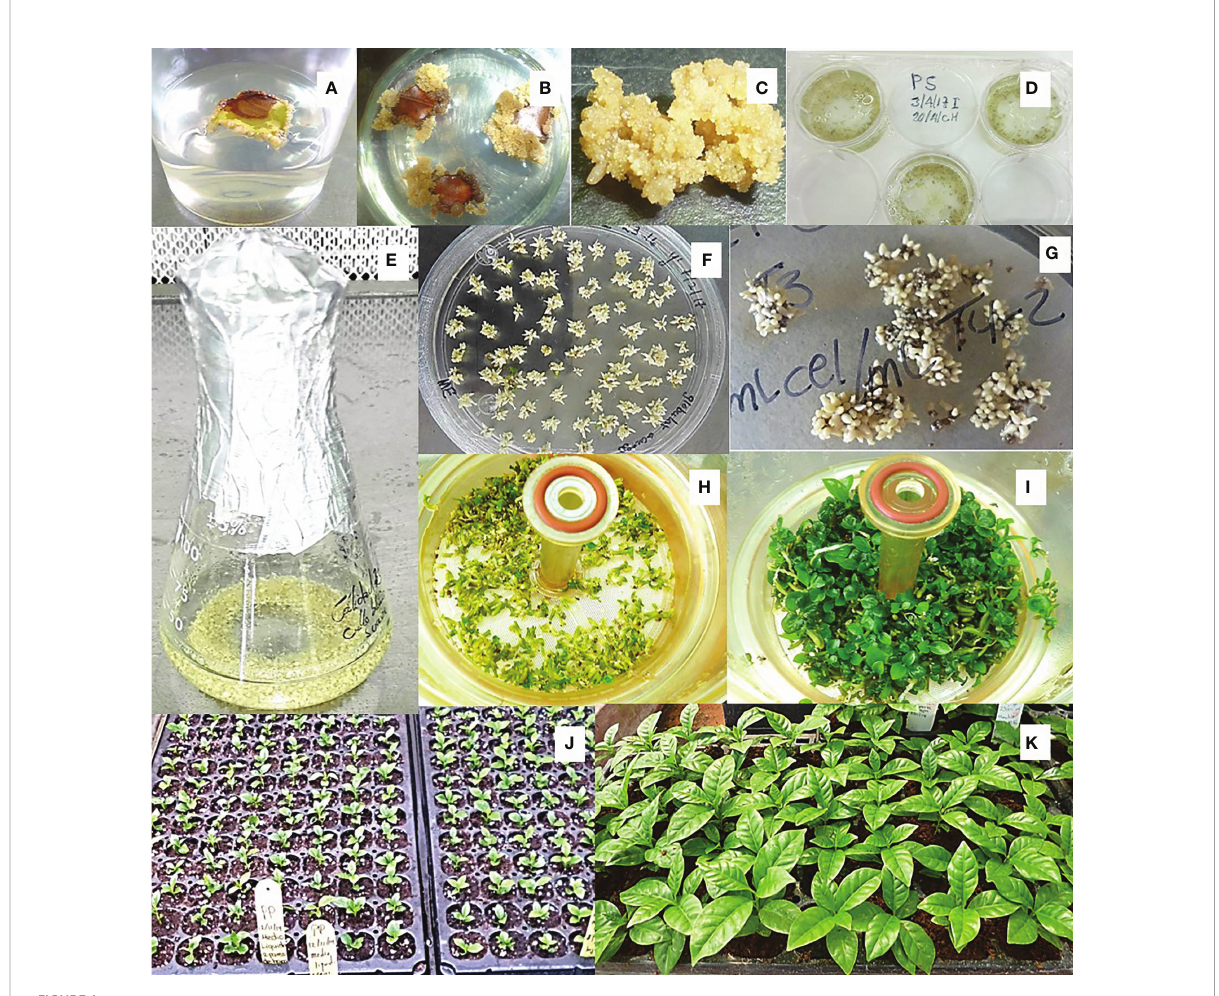
FIGURE 1 Induction and multiplication of EC and regeneration of somatic embryos. (A) Explant after one month of culture in darkness in the T1 medium, showing callus cicatrization; (B) brown color explants showing the EC; (C) mass of friable EC; (D) initiation of cellular suspensions in multi-cavity dishes with liquid T3 medium; (E) establishment of ECS in Erlenmeyer fl asks; (F) regeneration of EC on semi-solid Yasuda medium; (G) regeneration of ECS on fi lter paper in semi-solid T4 medium; (H) torpedo embryos in the germination phase at RITA ® ; (I) embryos in conversion phase in RITA ® ; (J) plants starting the acclimatization phase; (K) plants at the end of the acclimatization